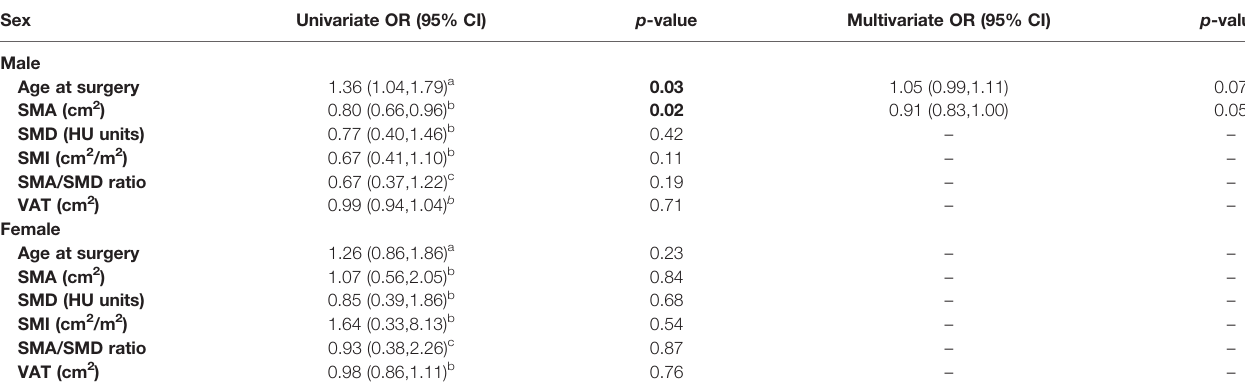
TABLE 5 | Univariate and multivariate risk estimates analysis for any complication, by sex.